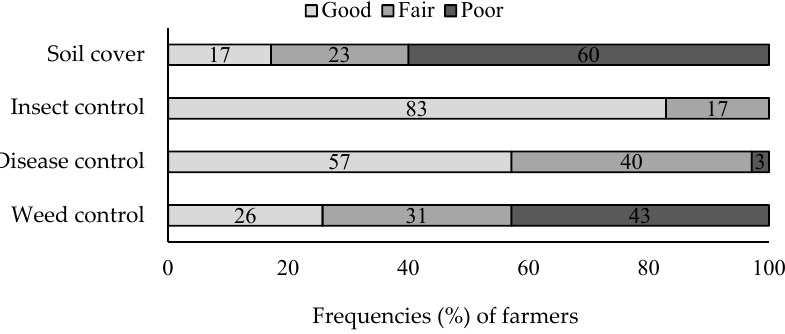
Figure 2. Assessment of CA fields based on the soil cover and pest control (weeds, insects and diseases) ( n = 35).